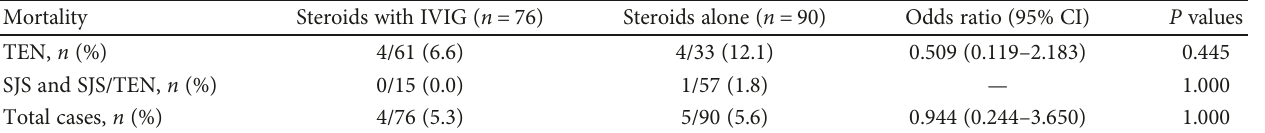
Table 6: A comparison of mortality rate between combination treatment of steroid with IVIG versus steroid